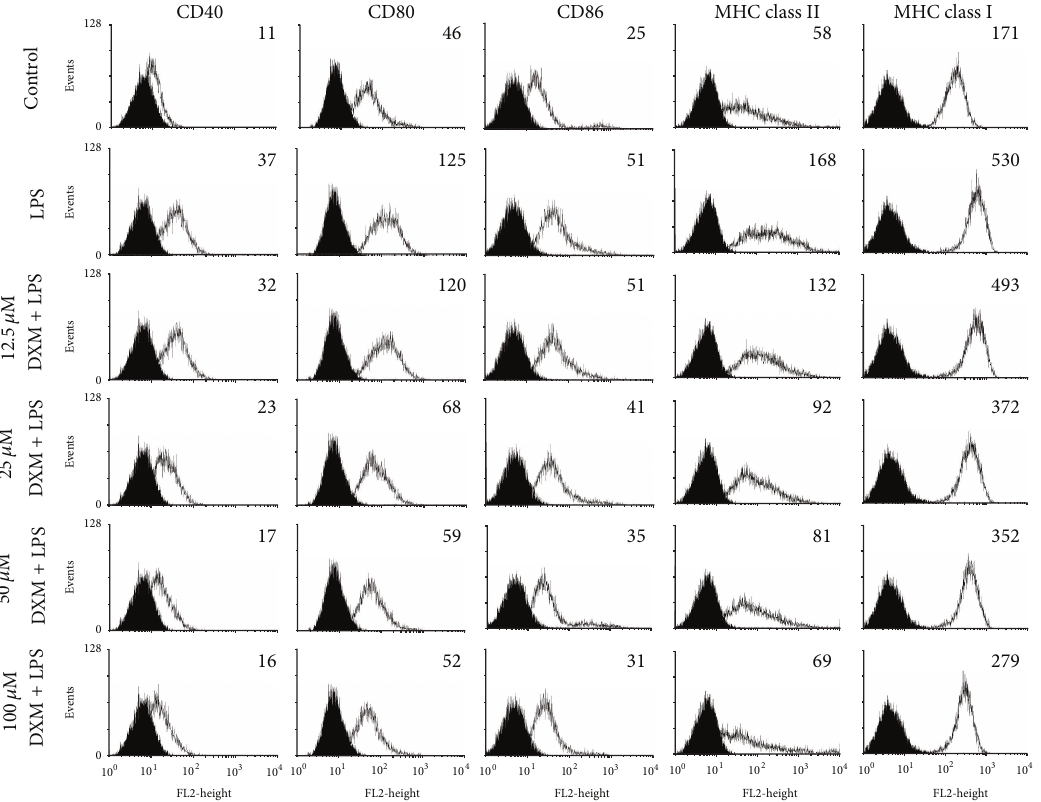
Figure 1: DXM reduces the expression of immunomodulatory cell surface markers in LPS-induced BMDCs. Immature BMDCs were stimulated with 100ng/mL LPS with or without DXM for 18h. Control groups were treated with PBS alone. After incubation, the expression of the surface markers CD40, CD80, CD86, MHC class I and MHC class II was analyzed by flow cytometry with fluorescently labeled Abs. The gray-filled area represents staining with an isotype-matched control Ab. The geometric mean fluorescence intensity (GMFI) of LPS or LPS+DXM is indicated. All data are representative of three independent experiments showing similar